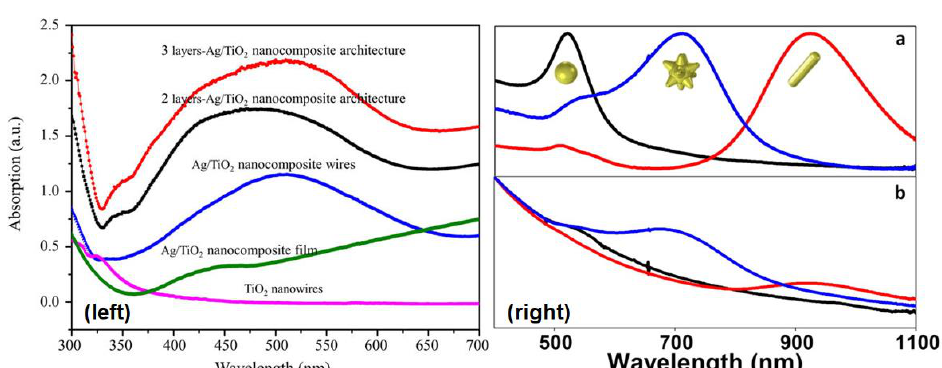
Figure 14. One application of plasmonic photocatalysis is to help extend the optical absorption capabilities of semiconductor photocatalysts, such as TiO 2 (that largely absorb in the UV-Vis range) to visible photons. LSPR peaks in the visible spectral range for various cross-architectures of Ag/TiO 2 plasmonic nanostructures (Left), as utilized in the work of Zhao et al. [176] Reprinted with permission from Ref [176] with attribution and adherence to Creative Commons Attribution License (CC BY) 4.0. Similarly, Castillo et al. [177] present (Right, ( a )) the UV-vis-NIR spectra of free Au nanoparticles of varying structures from nanospheres (black), nanostars (blue), and nanorods (red), along with that of the UV-vis-NIR spectra of the same Au nanoparticles after they are adsorbed onto SiO 2 beads following coating with TiO 2 nanoparticles: SiO 2 @Au nanospheres@TiO 2 (black), SiO 2 @Au nanostars@TiO 2 (blue), and SiO 2 @Au nanorods@TiO 2 (red). Thus, they are able to identify the unique absorption signatures of the three different morphologies along with a host of other properties including the locations of plasmon modes as evidenced by the peaks, and the fact that the UV-vis spectra of the composite structures (Right, ( b )) display strong absorption bands at longer wavelengths. Reprinted with permission from Ref [177] Copyright American Chemical Society (2016).